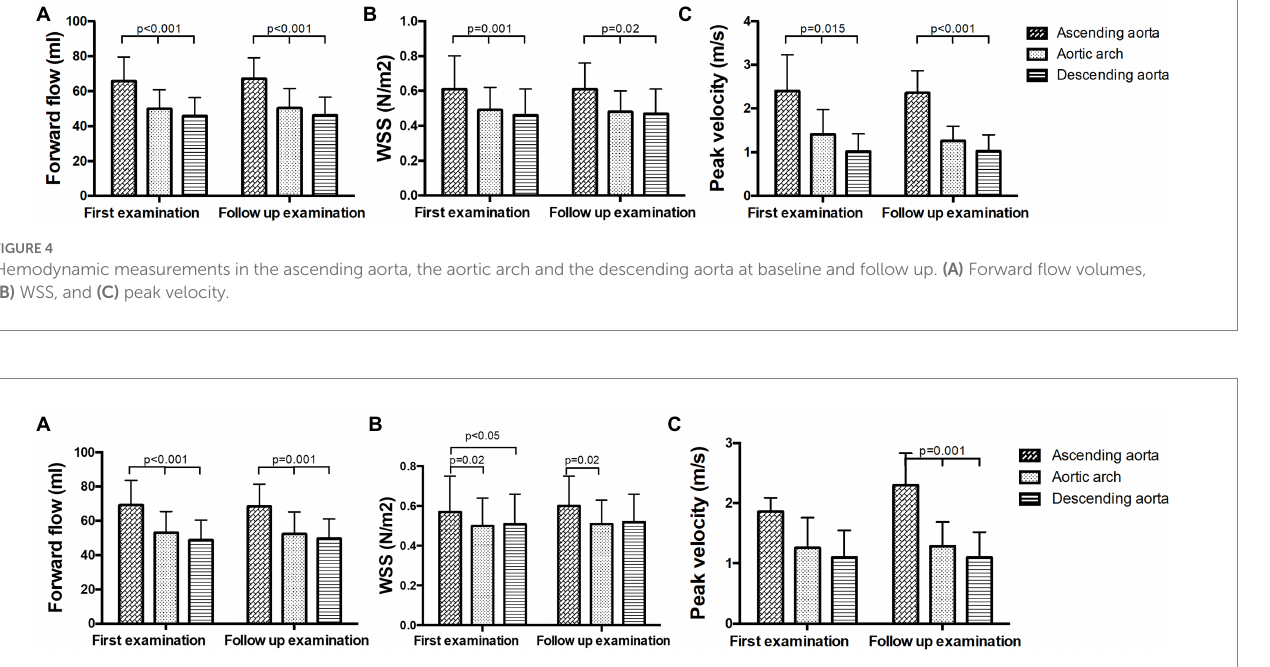
FIGURE 5 Hemodynamic measurements in non-operated patients in the ascending aorta, the aortic arch and the descending aorta at baseline and follow up. (A) Forward flow volumes, (B) WSS, and (C) peak